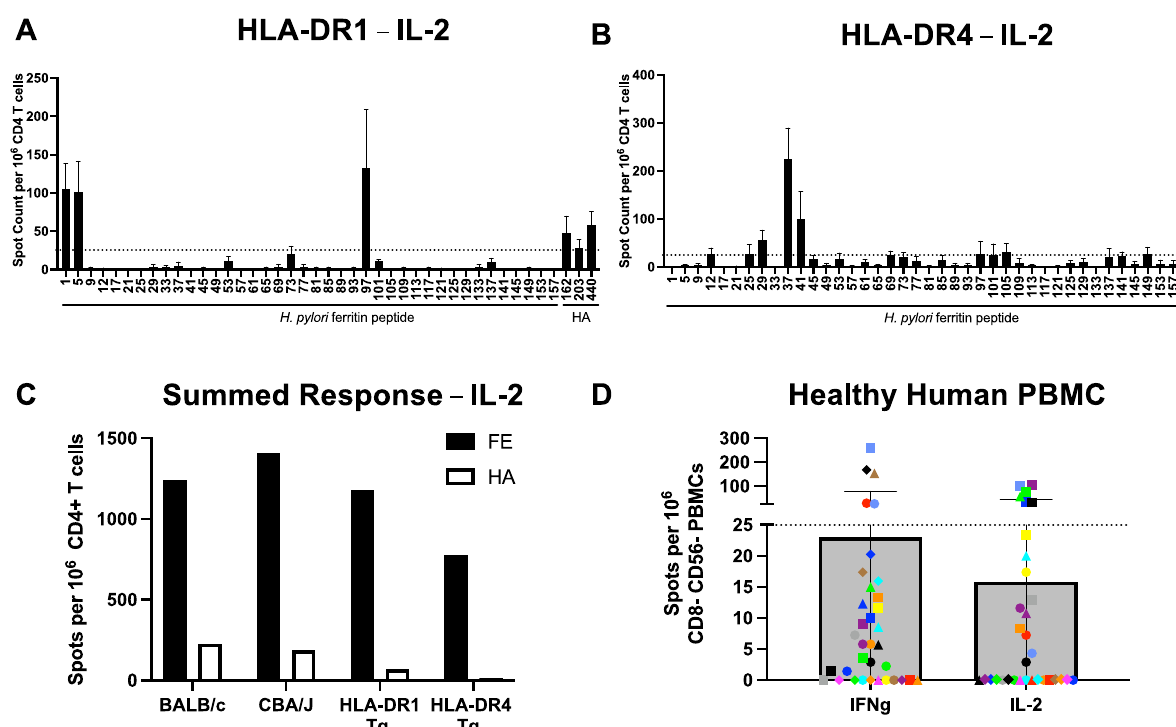
Fig. 2 De fi ning immunodominance of the CD4 T cell repertoire in human MHC-II haplotypes. Identi fi cation of immunodominant ferritin epitopes was performed by IL-2 cytokine ELISpot following immunization with full length HA-ferritin nanoparticles. Puri fi ed CD4 T cells were restimulated with peptides spanning the sequence of H. pylori ferritin and major HA peptides. Experiments were conducted in transgenic mouse models expressing A HLA-DR1 and B HLA-DR4 human MHC class II alleles. Data are shown as the mean and SEM of three independent experiments of fi ve pooled mice per group. C Summed cytokine response by antigen speci fi city across murine and human MHC class II molecules used in Figs. 1 and 2. D PBMC from 36 healthy human donors with unknown history of H. pylori infection were stimulated with a peptide pool spanning the entire sequence of H. pylori ferritin and plated in IL-2 and IFN γ cytokine ELISpot. Information about human donors is presented in Table 3. Data are shown as the mean and SD of the subjects